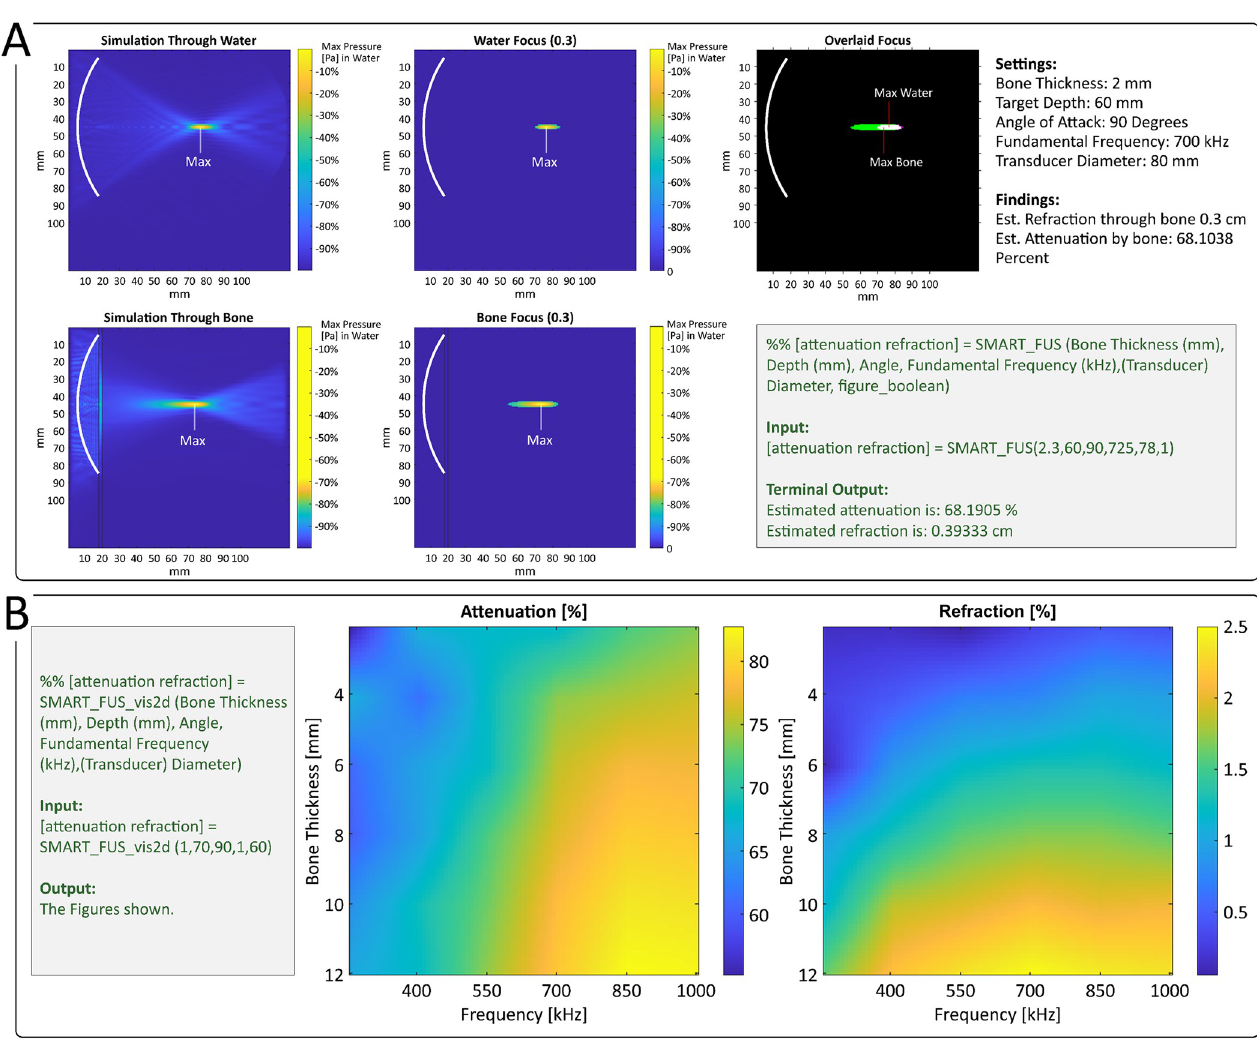
Fig 1. Primary graphical outputs from SMART_FUS. A) SMART_FUS estimates attenuation and refraction of specific inputs through linear interpolation and also provides a depiction of the simulation with parameters nearest the inputs. Here, a simulation conducted with a bone thickness of 2mm, target depth of 60mm, angle of entry of 90 degrees, a fundamental frequency of 700kHz, and a transducer diameter of 80mm is shown both when performed through a medium containing bone and when performed through a medium containing only water. The -3dB focal region (equivalent to the region exposed to 50% or more of the maximum intensity) is depicted to the right of the full simulations. The point of maximum intensity is highlighted. Finally, against a black background, these -3dB focal regions are overlaid and their points of maximum intensity highlighted again to clearly demonstrate the impact of bone on focal properties. It is important to note that this output would be generated if a close but not identical parameter set were inputted (e.g., with a bone thickness of 2.5mm and all other parameters remaining constant). However, the estimated attenuation and refraction with this unique parameter set would be generated through interpolation and output in the MATLAB terminal. B) A sample output from the script SMARTF_FUS_vis2d.m. Here, the user selected to visualize the impact of bone thickness and carrier-wave frequency at specific values for the remaining three free parameters. This 2-dimensional space is shown for both attenuation and